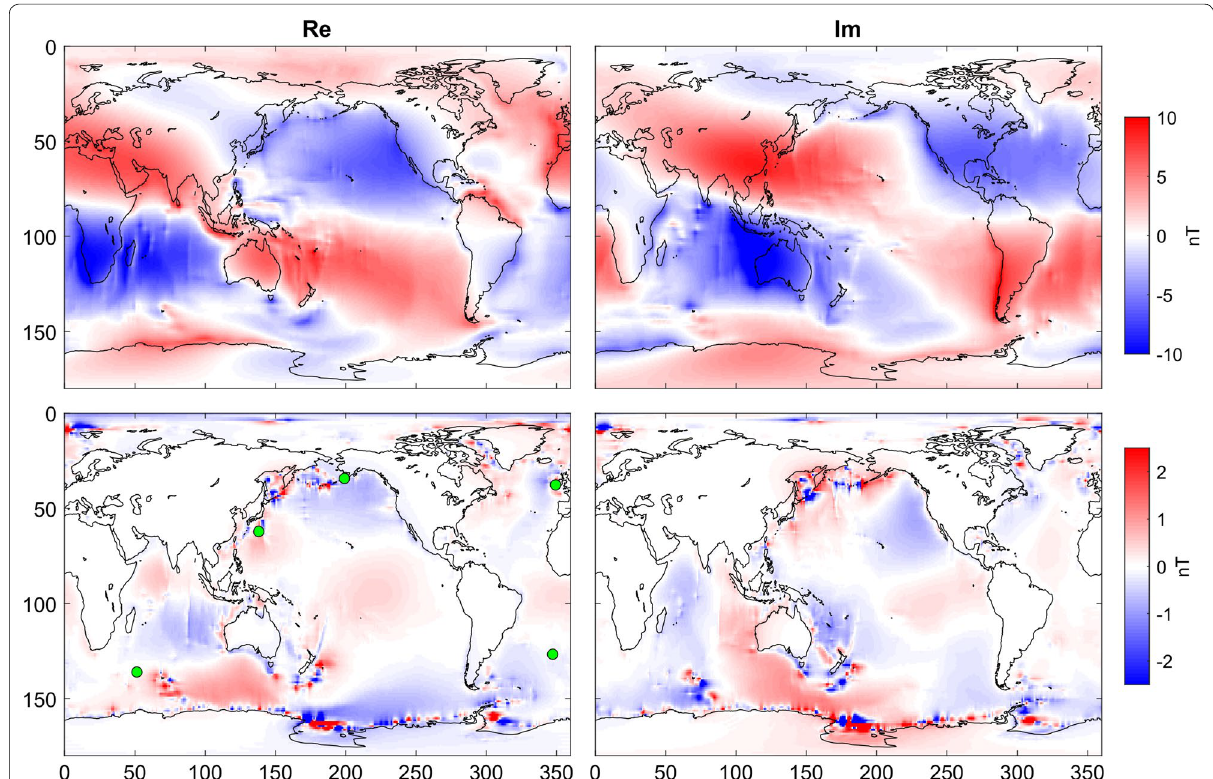
Fig. 15 Modeled Z component at a period of 24 h at the sea level. Top and bottom are the Sq and tidal field, respectively. Left and right are the real and imaginary parts, respectively. Note the different scales for top and bottom plots, as well as with respect to the X , Y component plots. Because of the continuity of the Z component across the ocean column, Z at the sea floor is not shown